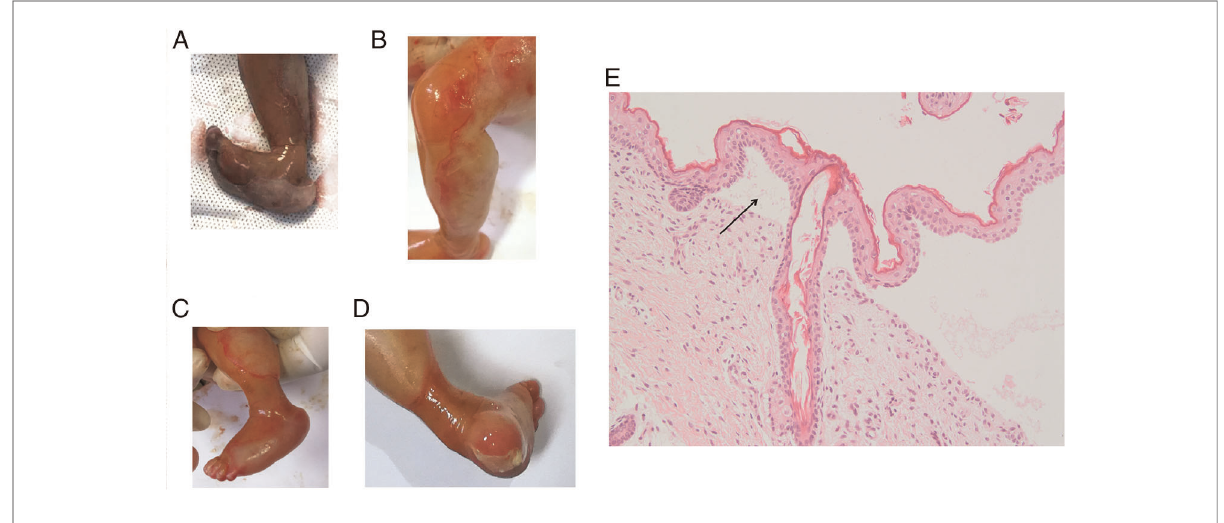
FIGURE 2 Clinical photographs and HE staining results of an epidermis blister from the affected fetus in the family. ( A ) Picturestaken immediately after induction of labor. ( B – D ) Photos taken after 12h of refrigeration after induction of labor. Toe dorsi fl exion was relieved after refrigeration. ( E ) HE staining picture of the epidermis blister. The magni fi cation is 200